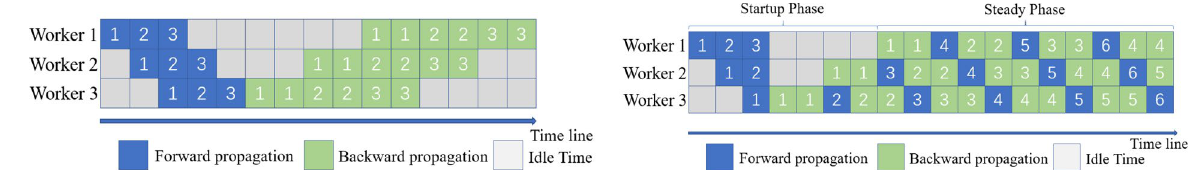
Fig. 3 Two mainstream techniques of pipeline model